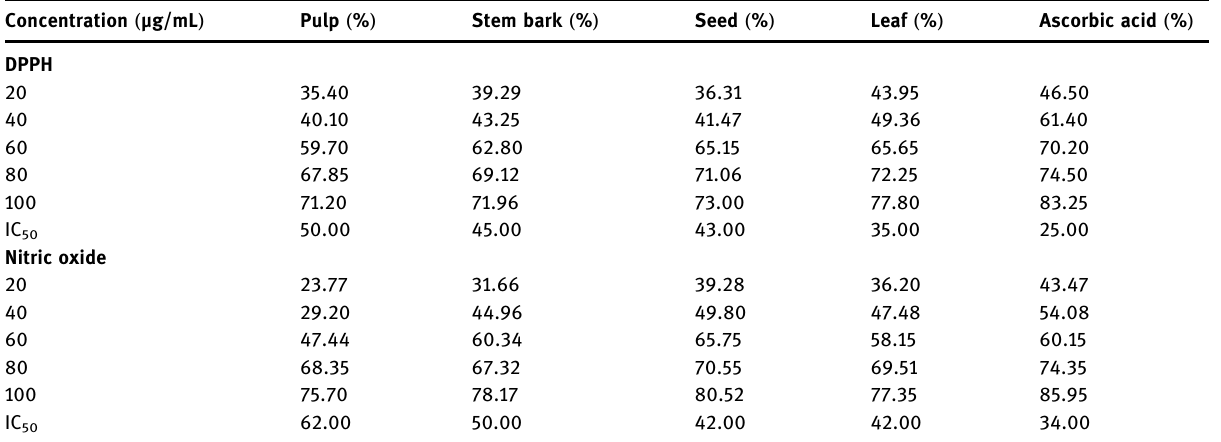
Table 6: DPPH inhibition and scavenging of nitric oxide by the methanolic extract of D. guineense plant Concentration ( µg/mL